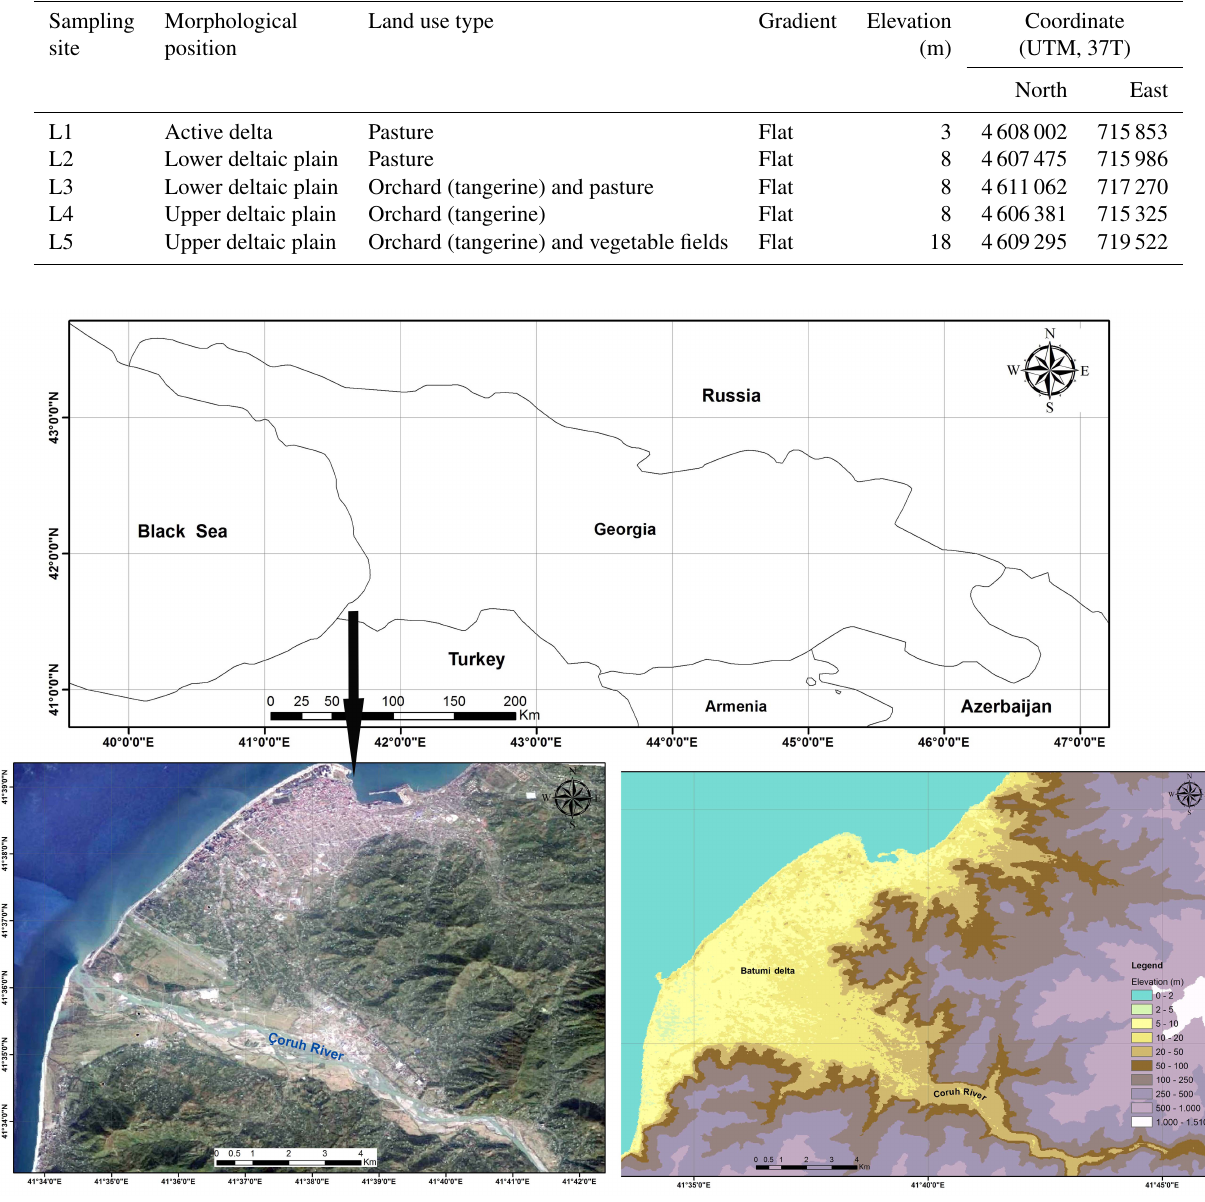
The OM content of the soils varied between 0.37 and 5.63 %, with a mean level of 2.53 %. It was determined that this level of OM content is relatively high for soils belonging to the sandy loam texture class (Marchetti et al.,